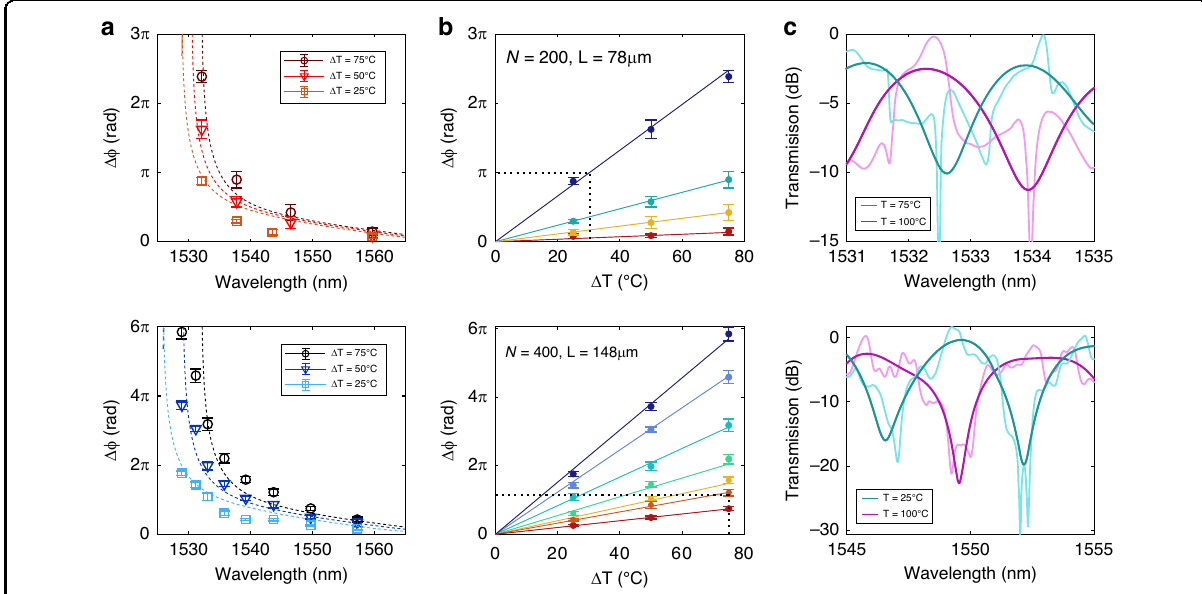
Fig. 5 Optical response for changes in the silicon temperature. a Experimental phase shift obtained in the fabricated bimodal 1D PhC interferometer as a function of the wavelength for the different temperature increments considered and for the N = 200 and N = 400 con fi gurations (upper and lower graphs, respectively). Dashed lines represent the band diagram simulation results, shifted 5 nm as in the previous case. b Evolution of the phase shift measured for a linear increment in the chip temperature. For the N = 200 con fi guration in the upper graph, different minima interference wavelengths at 1559.68 nm, 1546.51 nm, 1537.76 nm and 1532.13 nm are shown, with the increase in phase sensitivity represented by the shift from red to blue. For the N = 400 con fi guration, the minima interferences are placed at 1557.24 nm, 1549.73 nm, 1543.73 nm, 1539.23 nm, 1535.75 nm, 1533.08 nm, 1530.54 nm and 1528.95 nm and are represented by the lines transitioning from red to blue in the lower graph. Five different experimental measurements were carried out to obtain the error bars depicted. c The upper graph represents a close-up view of the normalized transmission spectrum for the N = 200 con fi guration (a bimodal 1D PhC length of 74 μ m) working in the slow light region for a temperature change of 25 °C, corresponding to an accumulated phase shift of 0.9 π . The lower graph represents a close-up view of the normalized transmission spectrum for the N = 400 con fi guration (a bimodal 1D PhC length of 148 μ m) working in the normal light region for a temperature change of 75 °C and corresponding to an accumulated phase shift of π . For both graphs, raw and fi ltered data are represented by light and dark colours,